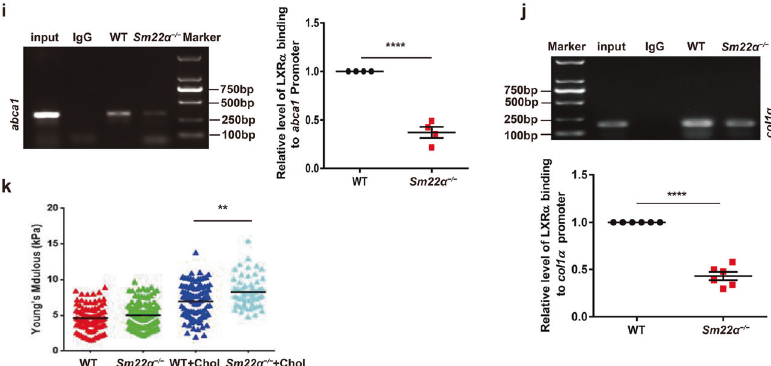
Fig. 2 Expression and activity of LXR α is abnormal in Sm22 α − / − VSMCs. a qRT-PCR and Western blot analysis of LXR α and LXR β in WT and Sm22 α − / − VSMCs treated with LXRs agonist T090 for 0, 12, 24, 48, and 72 h, respectively, ( n = 3). b qRT-PCR and western blot analysis of LXR α in WT VSMCs with or without cholesterol loading following knockdown of SM22 α ( n = 3). c qRT-PCR and western blot analysis of LXR α and SM22 α expression in Sm22 α − / − VSMCs transducted with Ad-GFP and Ad-GFP-SM22 α for 24 h ( n = 3). d Confocal microscopy images of LXR α and LXR β distribution in WT and Sm22 α − / − VSMCs. Scale bar, 10 µm. e Immuno fl uorescence staining for endogenous LXR α and LXR α -GFP in Sm22 α − / − VSMCs transducted with Ad-GFP and Ad-GFP-SM22 α or not. Scale bar, 10 µm. f qRT-PCR analysis of cholesterol intake (LDLR, SR-BI), ef fl ux genes (ABCA1, ABCG1) and sclerosis related genes (Col1 α , Eln) in WT and Sm22 α − / − VSMCs incubated with or without cholesterol ( n = 3). g The mRNA and protein levels of ABCA1 in WT and Sm22 α − / − VSMCs treated with cholesterol for 0, 12, 24, 48, and 72 h, respectively ( n = 3). h ORO staining of WT and Sm22 α − / − VSMCs stimulated with cholesterol for 0, 24, 48, and 72 h, respectively, and quanti fi cation of positive ORO staining. Scale bar, 20 μ m. i The binding activity of LXR α to the promoter of abca1 gene was decreased in Sm22 α − / − VSMCs ( n = 4). j ChIP and RT-PCR detected LXR α binding to col1 α promoter in WT and Sm22 α − / − VSMCs ( n = 6). k The Young ’ s modulus of WT and Sm22 α − / − VSMCs treated with or without cholesterol ( n = 120). Data and images are representative of at least three independent experiments. Data in a , g , and h were analyzed by Kruskal – Wallis rank sum test and two-way ANOVA. Data in b , c , f , i , and j were analyzed by unpaired t -test. N.S. not signi fi cantly different; * p < 0.05; ** p < 0.01; *** p < 0.001; **** p < 0.0001.